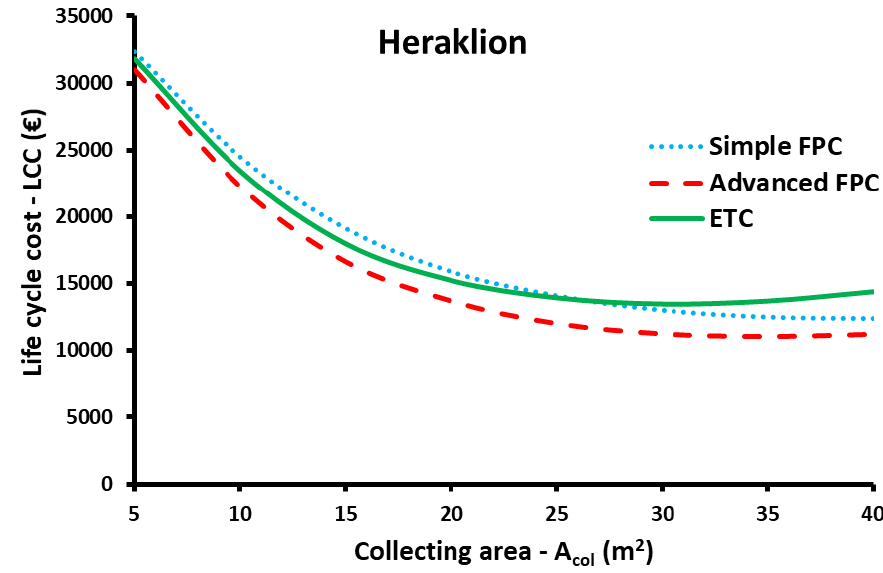
Figure 19. Life cycle cost for different collecting areas and collector types for Heraklion.